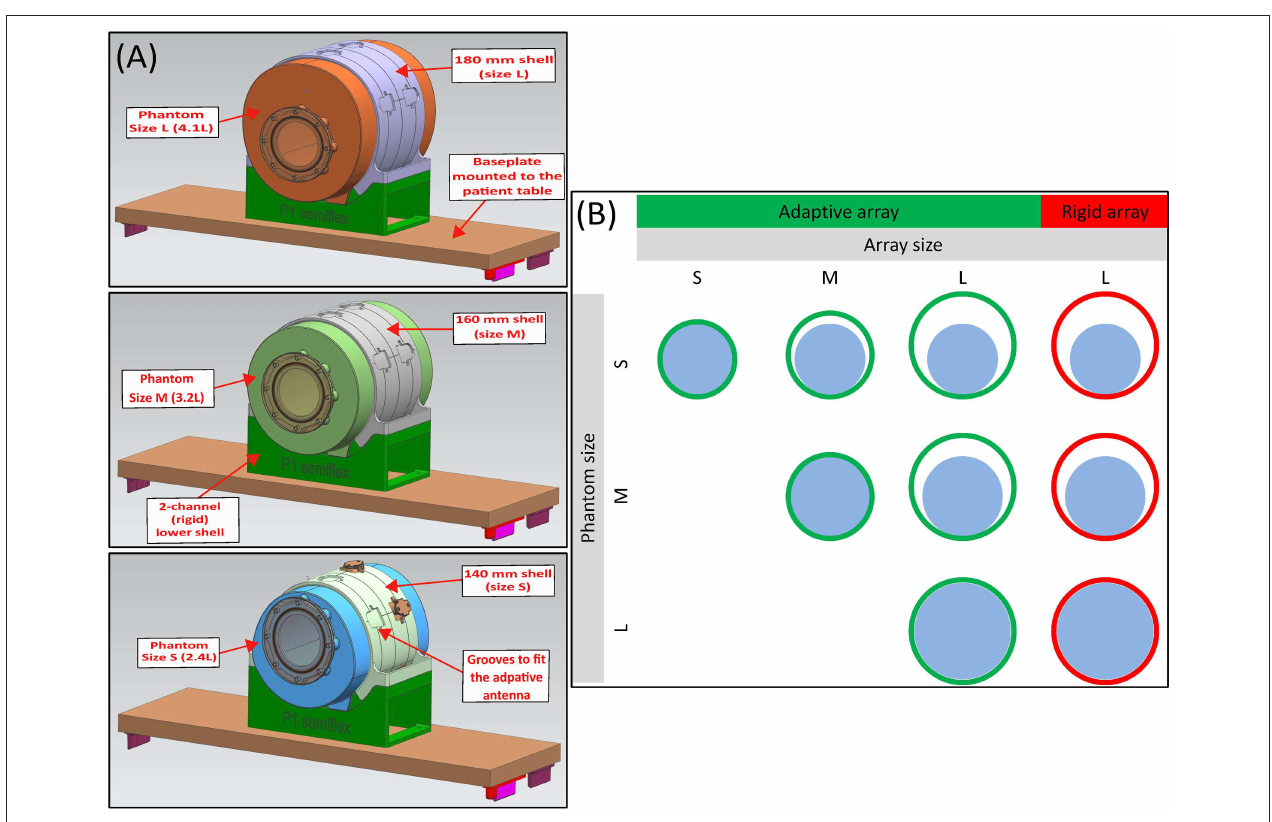
FIGURE 4 | (A) 3D CAD rendering of the adaptive array test setup with 4 stretchable (upper shell) loops and 2 rigid loops in the bottom shell. The adaptive array is evaluated using three differently sized knee phantoms of size L (180mm diameter, 4.1l), M (160mm diameter, 3.2l), and S (140mm diameter, 2.4l). (B) To directly compare the 4-channel adaptive array with the four stretchable loops to the 4-channel reference array (each one connect to the 2-channel lower shell upon each measurement), a shell of size 180mm is 3D laser sintered and the adaptive loops are mounted on it, while the three differently sized knee phantoms (L, M, S) were